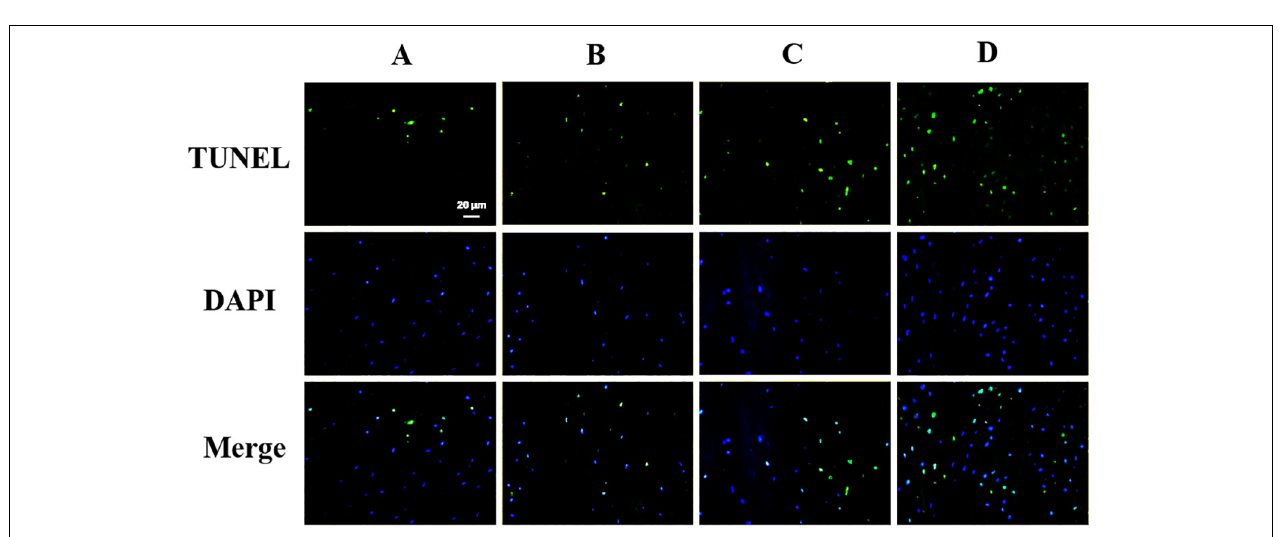
FIGURE 6 | TUNEL assay was performed to evaluate the apoptosis in nucleus pulposus cells (original magnification, × 400; scale bar, 20 µ